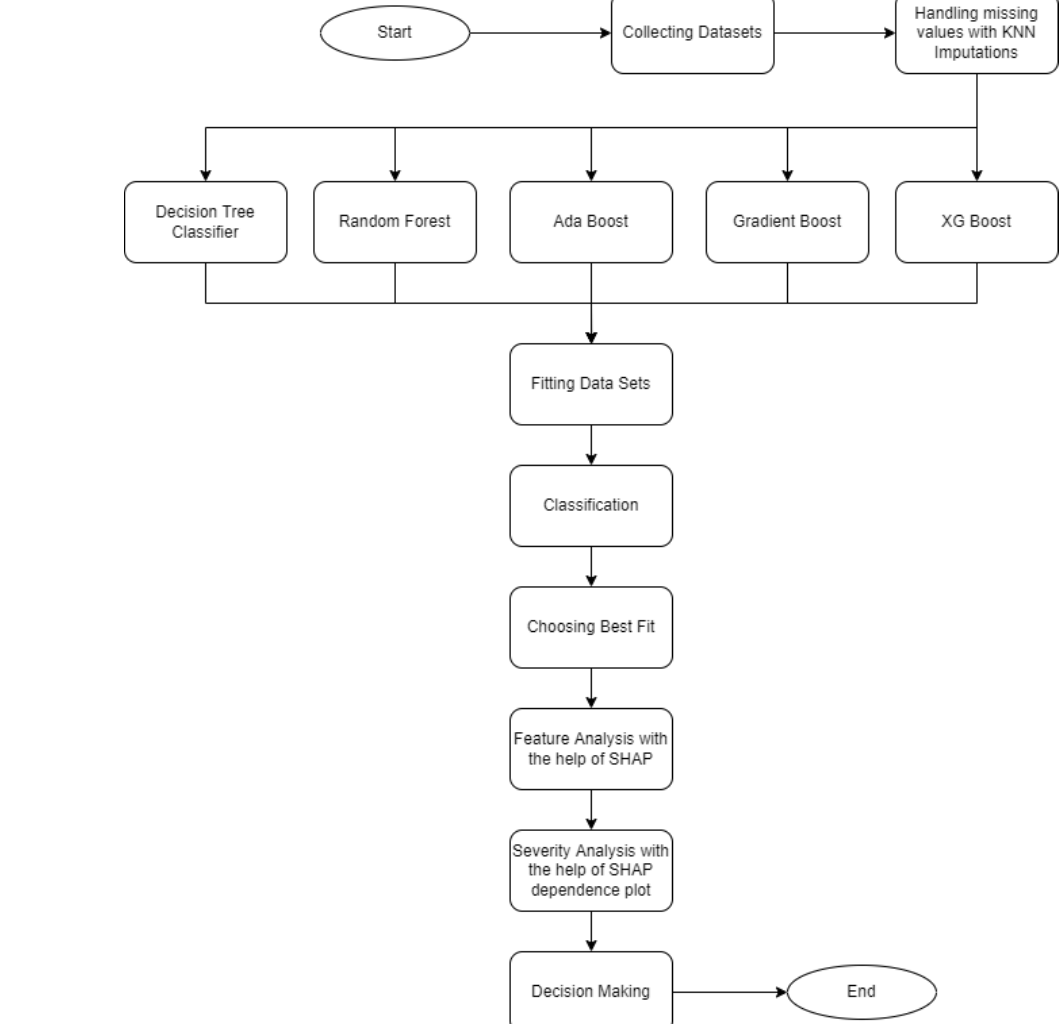
Figure 1. Top level overview of the dengue prediction model (VDengue